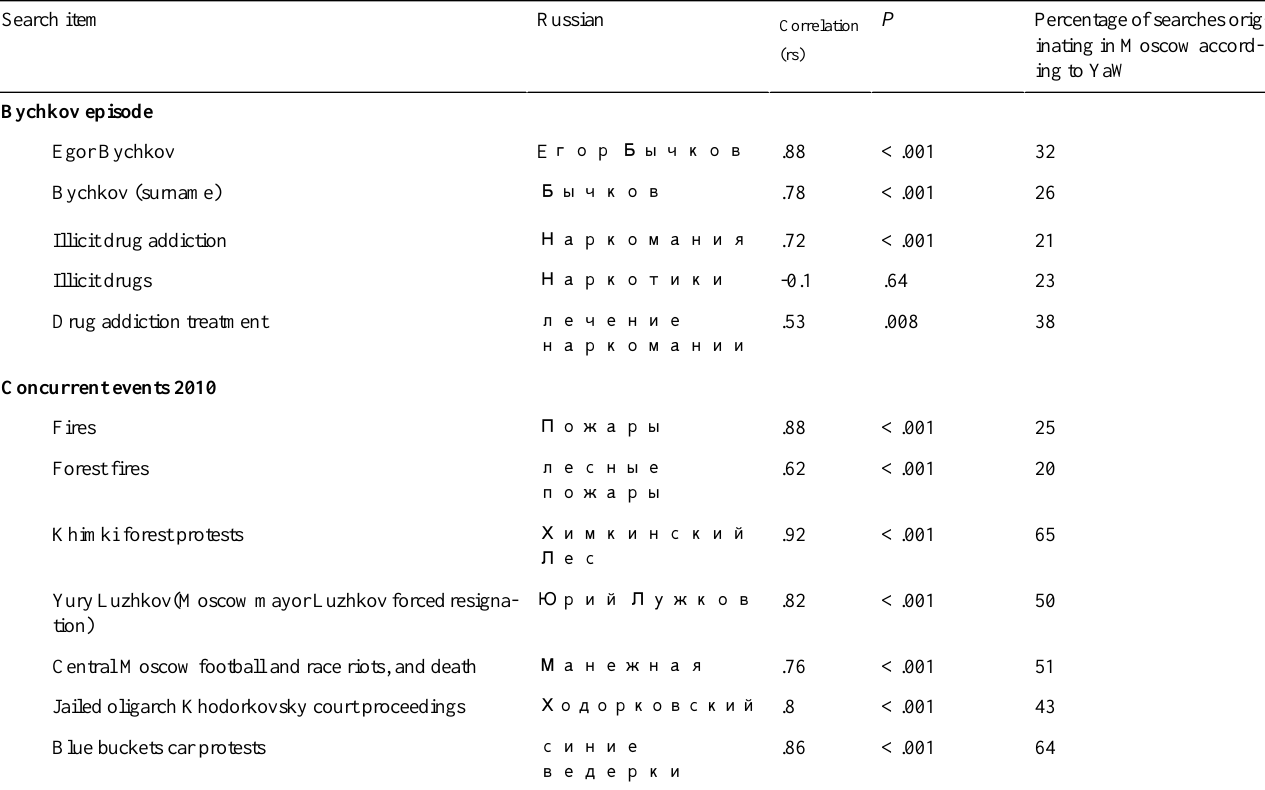
Table 3. Correlation between GIFS and YaW of monthly frequency of search terms from March 2010 to March 2012.